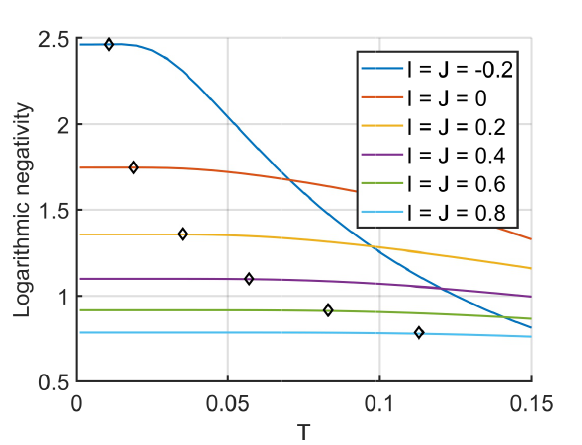
Figure 5: Temperature dependence of the entanglement at some points of the main I − J plane diagonal with K = − 1. For any point it exhibits two modes: constant one for low enough temperatures and decreasing for high T . The mode crossover points are marked by diamonds. The higher are the I , J values, the larger is the duration of the constant mode. See also Fig.